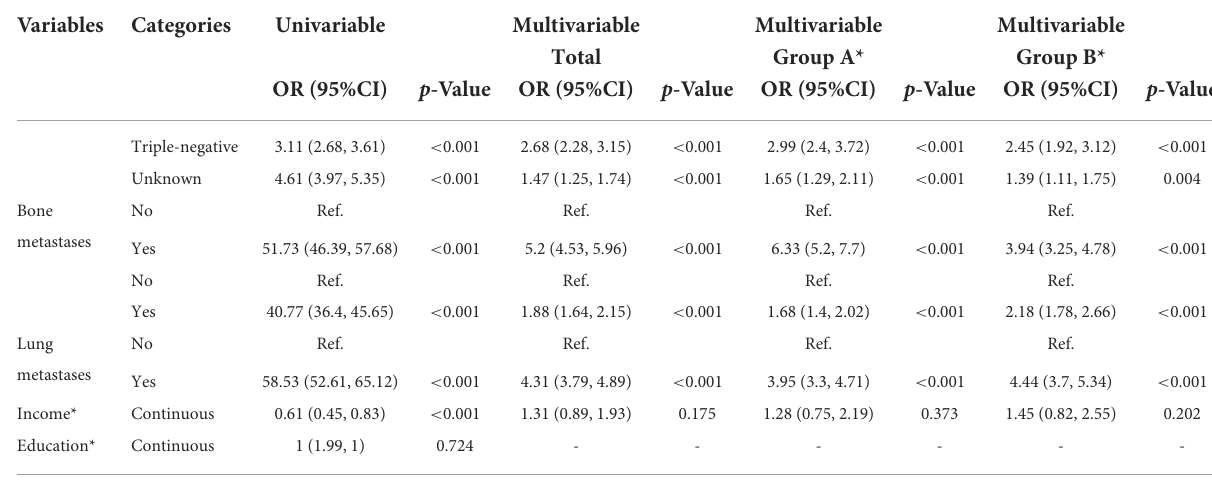
A median (interquartile range) of 16 (6–32) months was the time period of mortality ascertainment, corresponding to 1,042 deaths from all causes and 807 deaths caused by cancer.